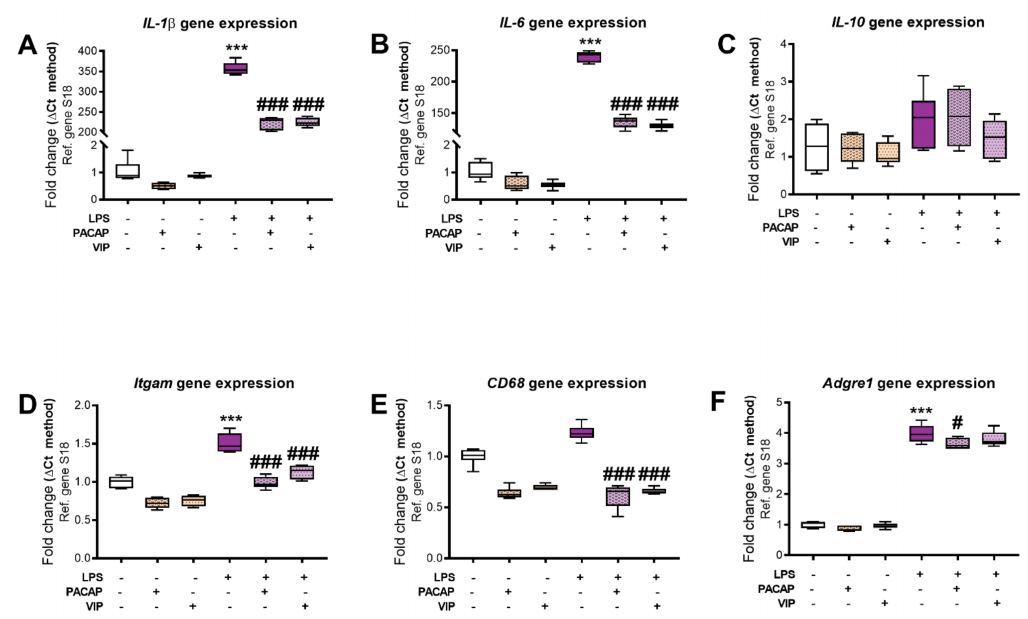
Figure 5. Transcript levels of inflammatory markers after treatment of BV2 cells with LPS alone or in combination with PACAP or VIP. Murine BV2 cells exposed (or not) to LPS (1 µ g/mL) for 24 h were co-treated with either PACAP or VIP, and mRNA levels were assessed by real-time qPCR. Expression of IL-1 β ( A ), IL-6 ( B ), IL-10 ( C ), Itgam ( D ), Adgre1 ( E ) and CD68 ( F ) are shown. Transcript levels were calculated using the Delta-CT method. Data represent the means of 5–6 samples for each group. Results are expressed as mean ± SEM. *** p < 0.001 vs. control, # p < 0.05 and ### p < 0.001 vs. LPS only, as determined by one-way ANOVA followed by Tukey post hoc test. IL-1 β : Interleukin 1-beta, IL-6 : Interleukin 6, IL-10 : Interleukin 10, Itgam : CD11b, Adgre1 : F4/80, CD68 : Cluster of differentiation 68, S18: ribosomal protein subunit